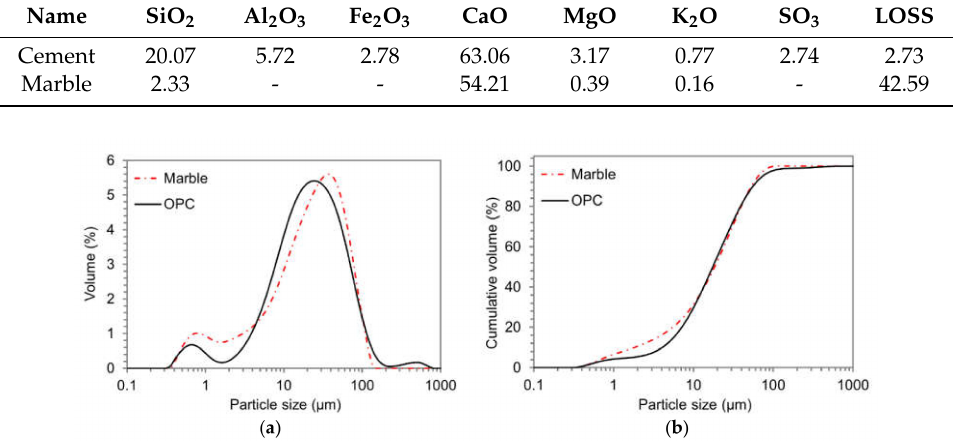
Table 1. Chemical composition of cement and marble powder (%).